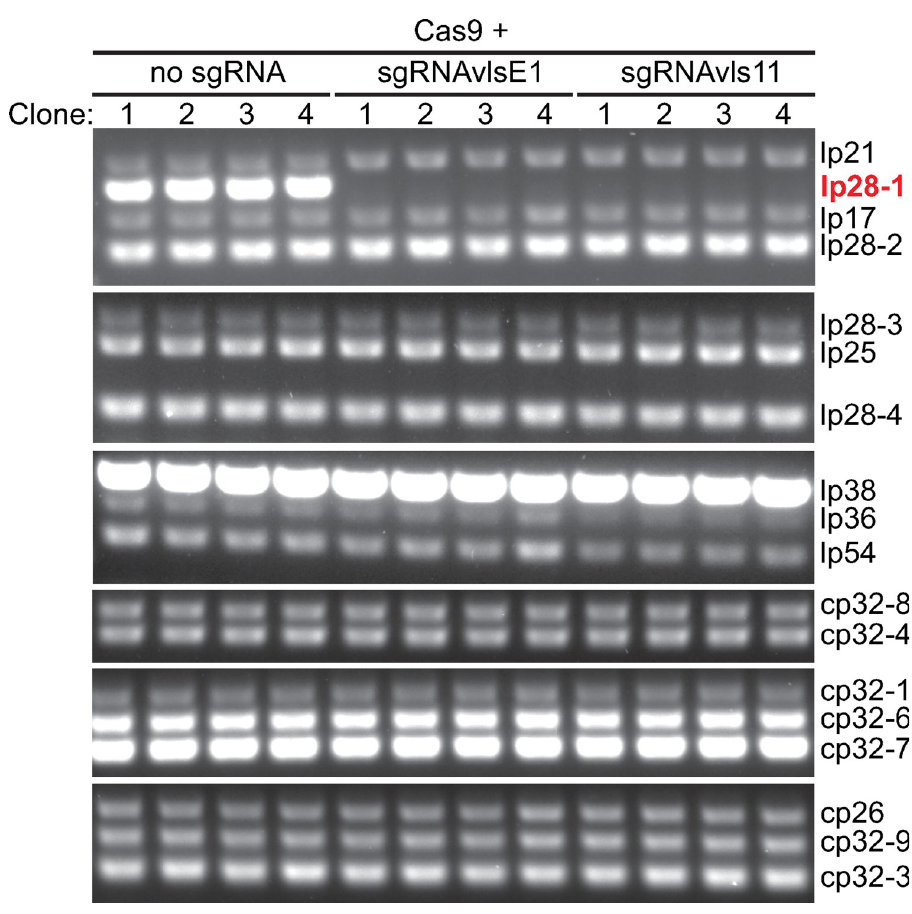
Fig 3. Targeting Cas9 activity to lp28-1 causes the loss of this plasmid from the cell population. Cells of B . burgdorferi strain K2 were electroporated with shuttle vectors expressing Cas9 WT and the indicated sgRNAs. Four clones obtained from each transformation were analyzed by multiplex PCR for the presence or absence of B . burgdorferi endogenous plasmids. The PCR reactions were grouped into six sets. The endogenous plasmids corresponding to each of the bands are listed on the right. Signal intensity was scaled to ensure that all positive bands could be seen. As a result, the intensities of some bands are saturated. For uncropped source images of the gels, please see S1 Fig.